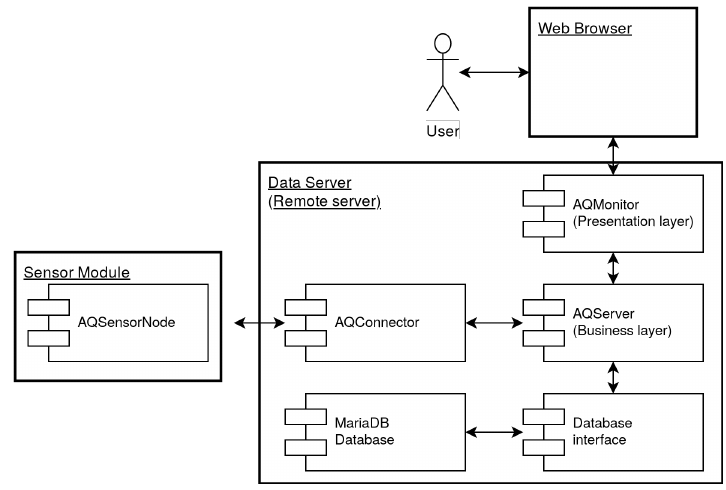
Figure 5. Software system